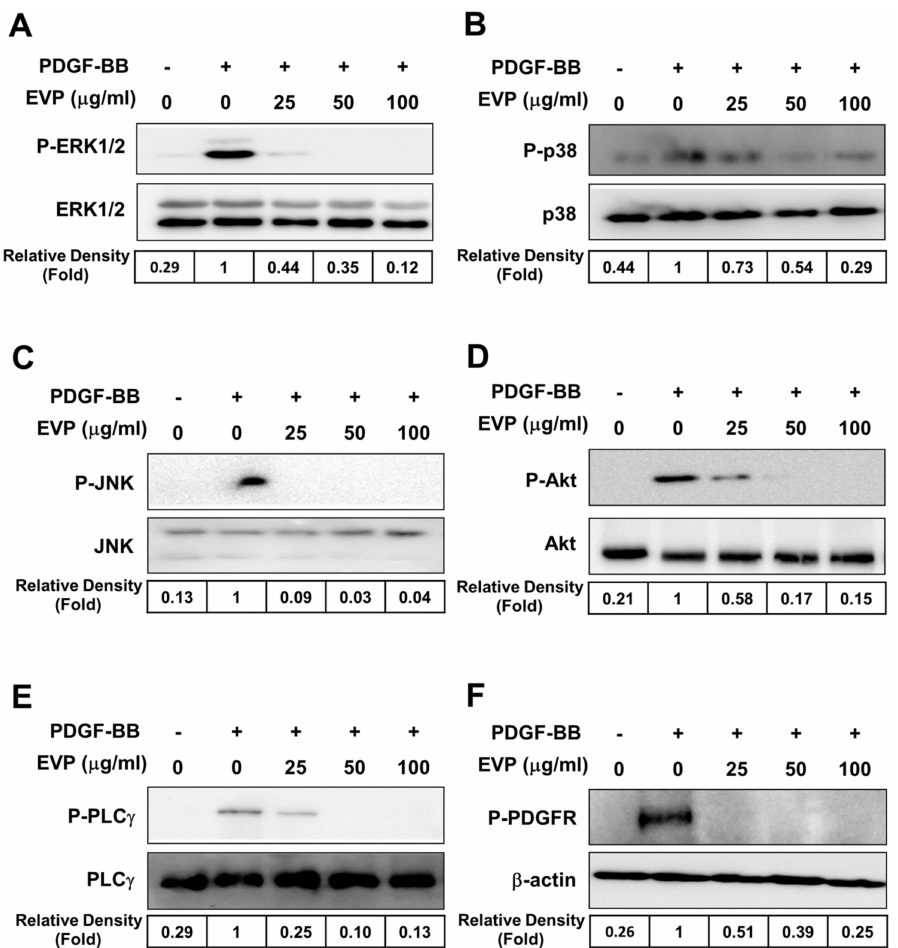
Figure 5. Effect of EVP on phosphorylated MAPKs and the PDGFR signaling pathway in PDGF- BB-induced VSMCs. Cells were harvested at the time the expression of each MAPK and PDGFR signaling protein was induced. Following treatment with or without EVP (0, 25, 50, and 100 µ g/mL), cells were stimulated with PDGF-BB. They were then lysed in lysis buffer and Western blotting was performed to determine the expression levels of ( A ) phosphorylated ERK (15 min), ( B ) phos- phorylated p38 (30 min), ( C ) phosphorylated JNK (30 min), ( D ) phosphorylated Akt (30 min), ( E ) phosphorylated PLC γ (within 10 min), and ( F ) phosphorylated PDGFR (within 5 min). Quantifi- cation of normalized densities for P-ERK, P-p38, P-JNK, P-Akt, P-PLC γ and P-PDGFR activities is shown. The images indicate the relative expression levels and inhibition of phosphorylation from three independent